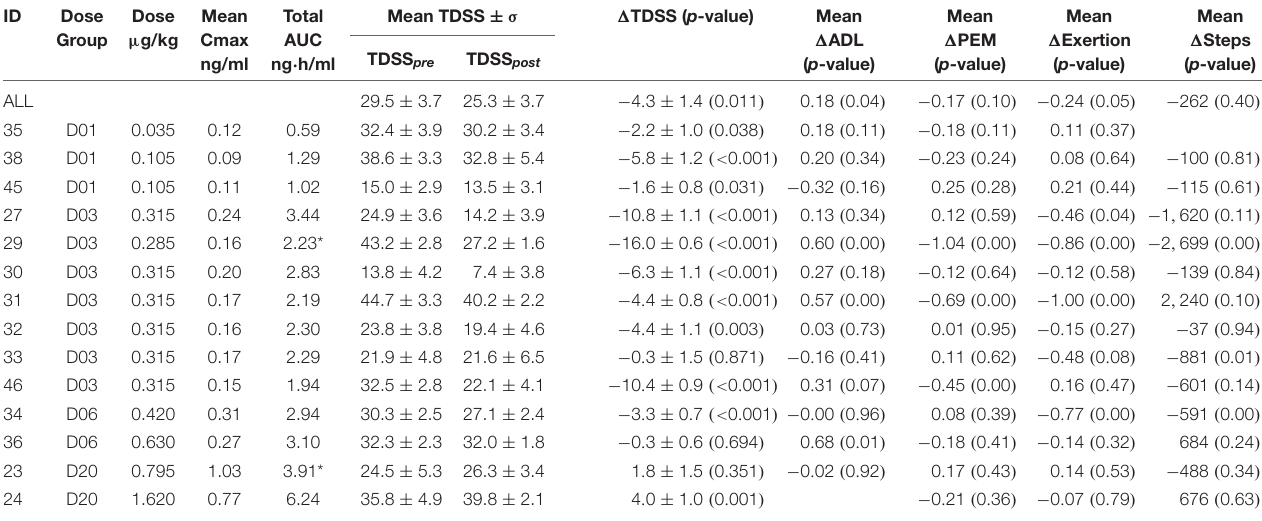
TABLE 2 | CT38s dose, pharmacokinetics, mean TDSS and activity, by patient. ID Dose Dose Mean µ g/kg Group